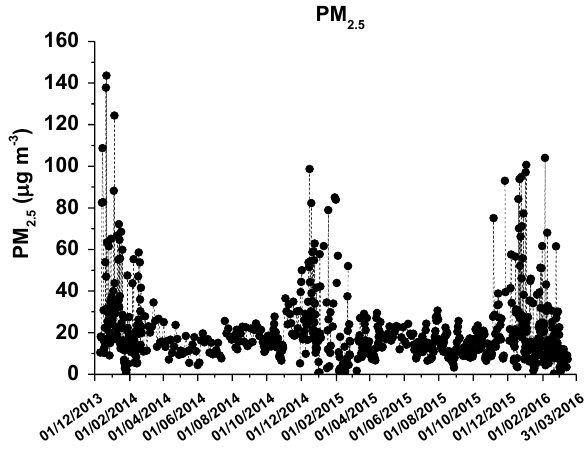
Figure 1. Daily PM 2 . 5 mass concentrations (µgm − 3 ) at Thissio sta- tion for the studied period from December 2013 to March